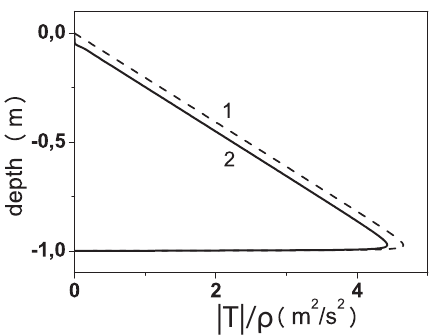
Figure 18. The profiles of the turbulent stress per unit mass in stationary flows of 1—linear viscous fluid ( τ y = 0); 2—Bingham fluid ( τ y / ρ = 0.2 m 2 /s 2 ). The results were obtained by the